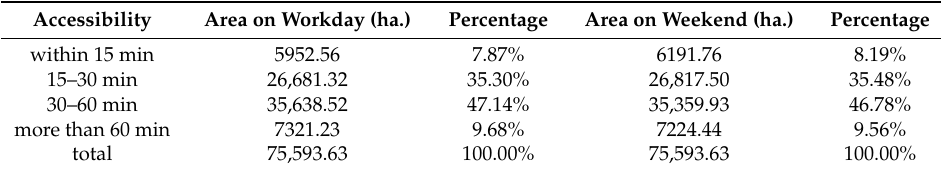
Table 4. Public transport accessibility scale.